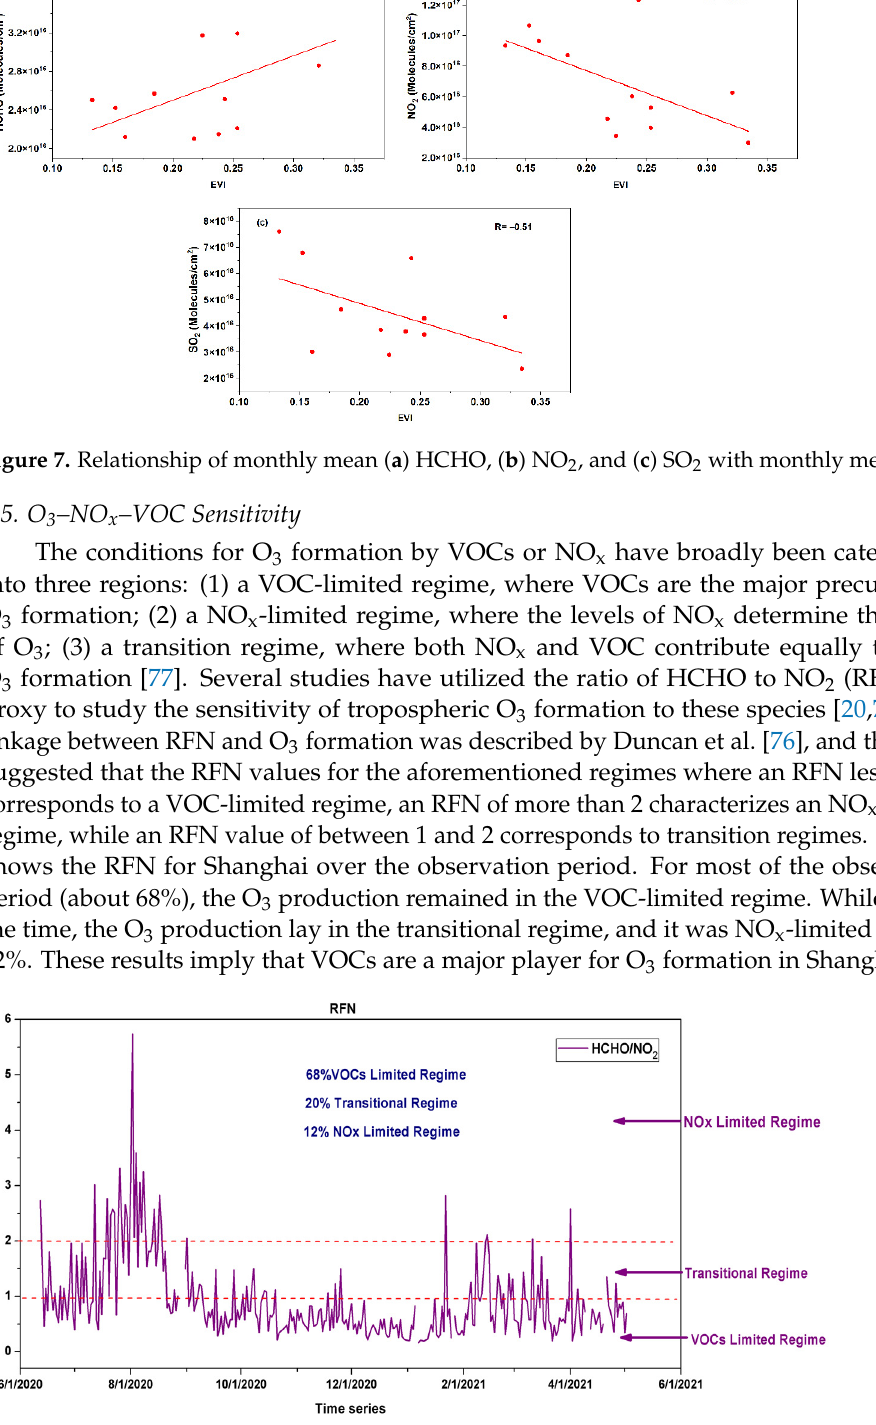
Figure 8. Daily mean RFN over Shanghai from June 2020 to May 2021.